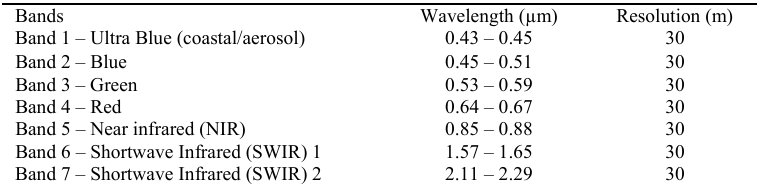
Table 1: Spectral characteristics of Landsat 8 bands used in the classification of inland wetlands (NASA, 2018)